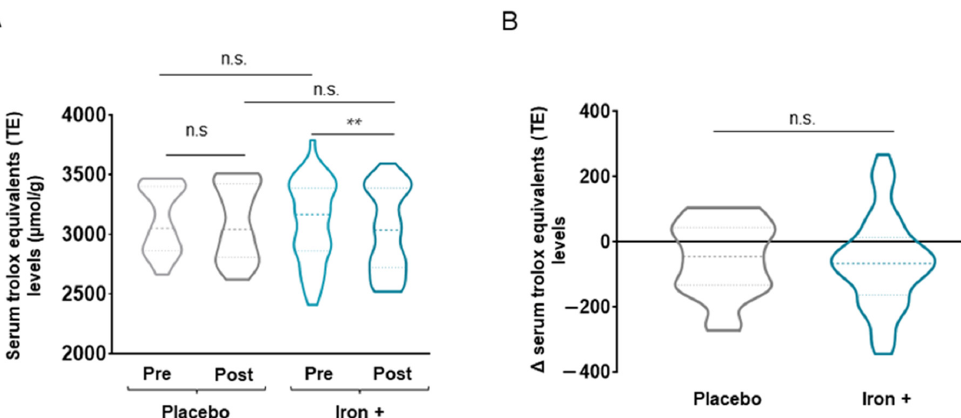
Figure 9. Violin plots of absolute Trolox equivalents levels in serum of all COPD patient groups ( A ) and delta (post-pre) of serum Trolox equivalents levels in placebo and iron-treated groups ( B ). The dashed line represents the median and the dotted lines the interquartile ranges. Statistical significance: n.s., no significance; ** p < 0.01 between post-iron and pre-iron